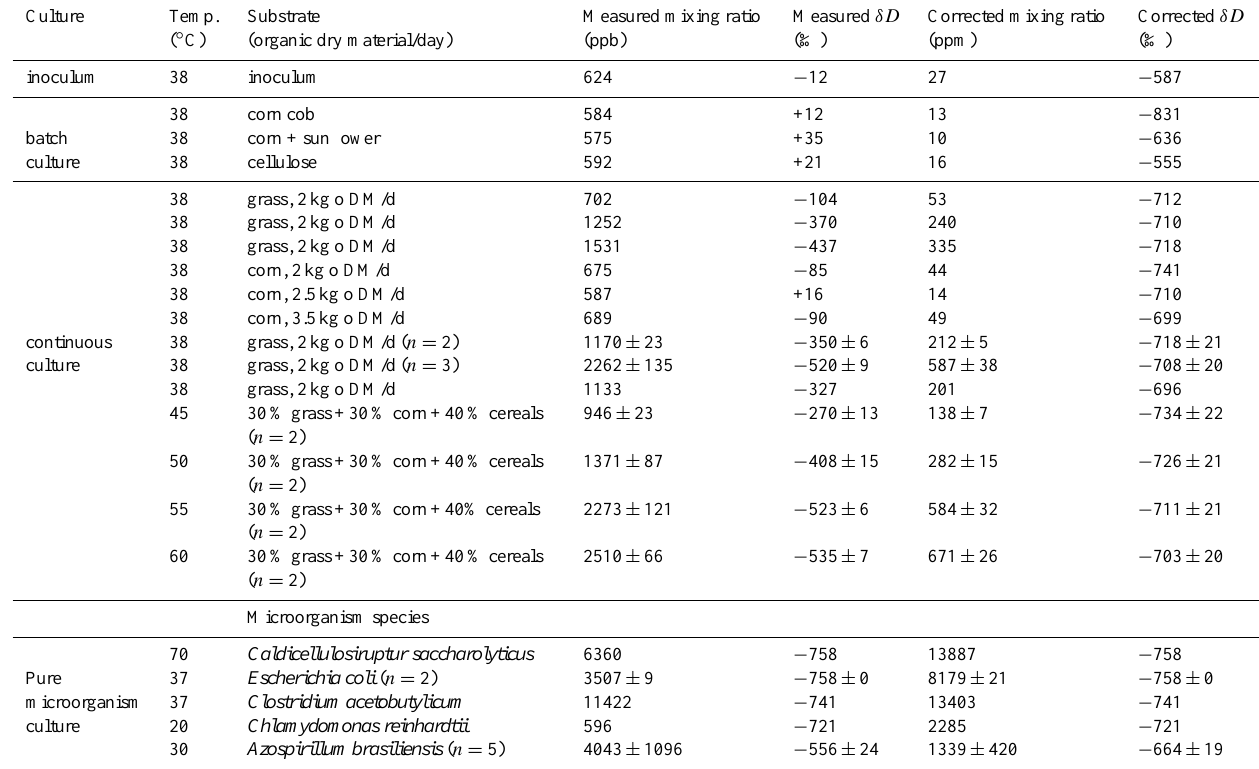
Table 1. Molecular hydrogen (H 2 ) mixing ratio and δD (vs. VSMOW) from different biogas production treatments and pure cultures. Columns 4 and 5 give the raw (i.e. measured) values for mixing ratio and δD , which are used in the Keeling plot in Fig. 1. Columns 6 and 7 give the final values of the pure sample after correction for the dilution with standard gas (with known H 2 mixing ratio of 546.2ppb, δD + 71 . 4‰, used for biogas samples) and H 2 free gas (used for pure microorganism culture samples), respectively. Substrate was added in units of kg organic dry material per day [o DM/d]. Some samples are measured in duplicate or more. Uncertainties in the table are given for the reproducibility of the measurements or calculations as the average of absolute deviation of data from their mean. For single measurements we assume a mean uncertainty of 4.1% for mixing ratios and 2.4% for δD